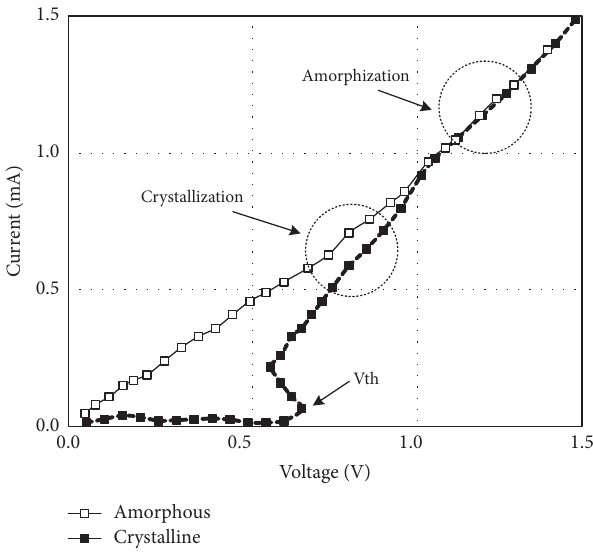
Figure 1: I-V characteristic curve of Ge